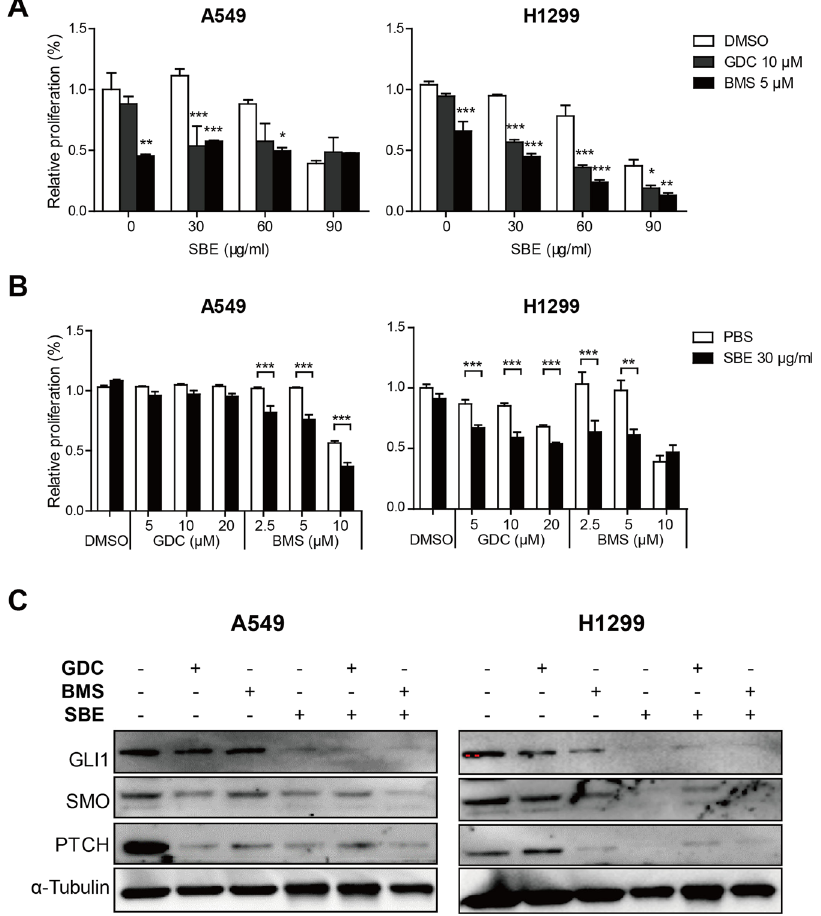
Figure 5. Downregulation of SMO magnifies inhibitory effects of SBE on NSCLC cell proliferation. ( A ) Proliferation assay indicating that GDC or BMS and various dose of SBE cooperatively repress NSCLC cell proliferation. ( B ) Proliferation assay showing that low dose of SBE sensitized anti-proliferative effects of SMO inhibitor (GDC and BMS) on A549 and H1299 cells. ( C ) Immunoblotting analysis demonstrating that SBE enhanced GDC or BMS-induced repression of GLI1, SMO, and PTCH on protein